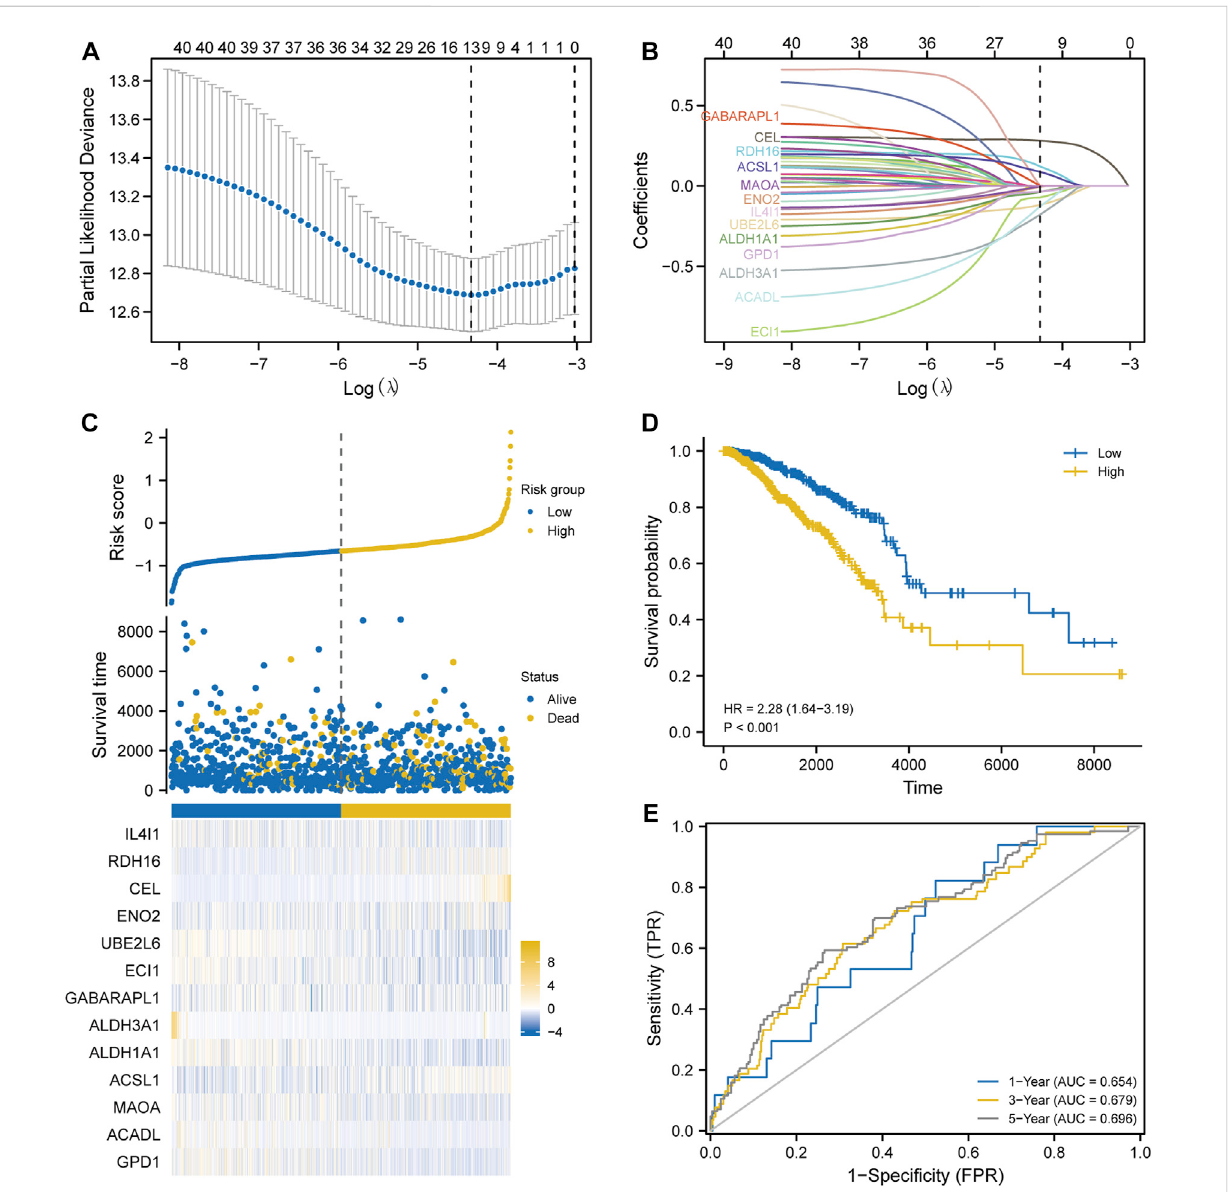
FIGURE 7 Modeling prognosis usingLasso analysis. (A) DeterminationoftheLasso coef fi cient. (B) Lasso variabletrajectory plot. (C) Riskfactorplot. (D) Survival analysis. (E) Receiver operating characteristic curve.Z.